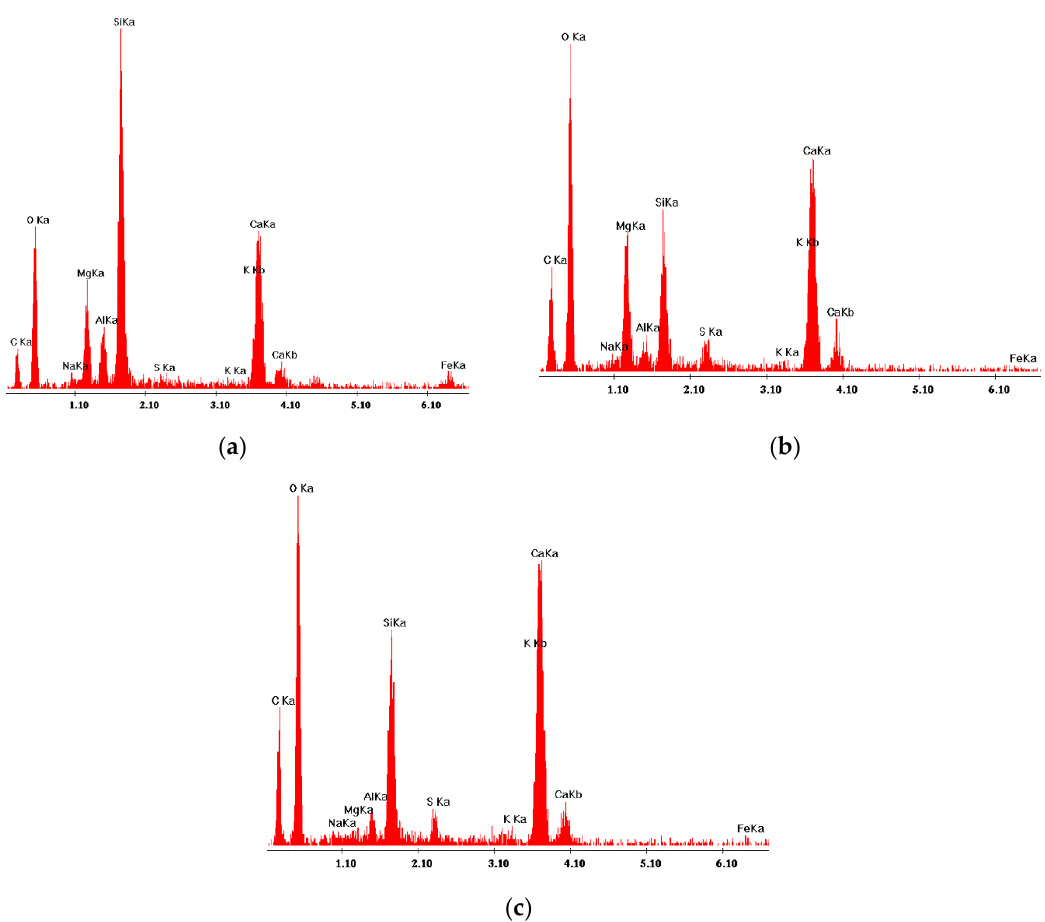
Figure 15. X-ray analysis in micro-areas indicated in Figure 14: ( a ) and ( b ) Basalt dust grains—points 1 and 3; ( c ) C–S–H phase—point 5. C–S–H was also found in points 2, 4, and 6, the X-ray analyses of which were not included.